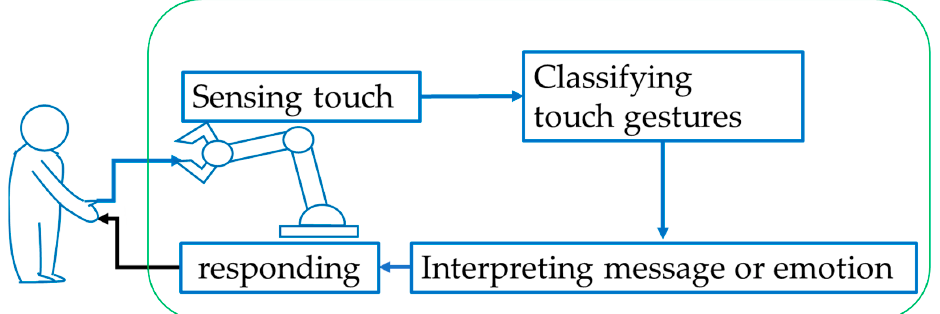
Figure 1. The proposed overall touch communication system with the two-step expressive gestures estimation. In this paper, we present the touch sensing and the classifying touch gesture blocs.